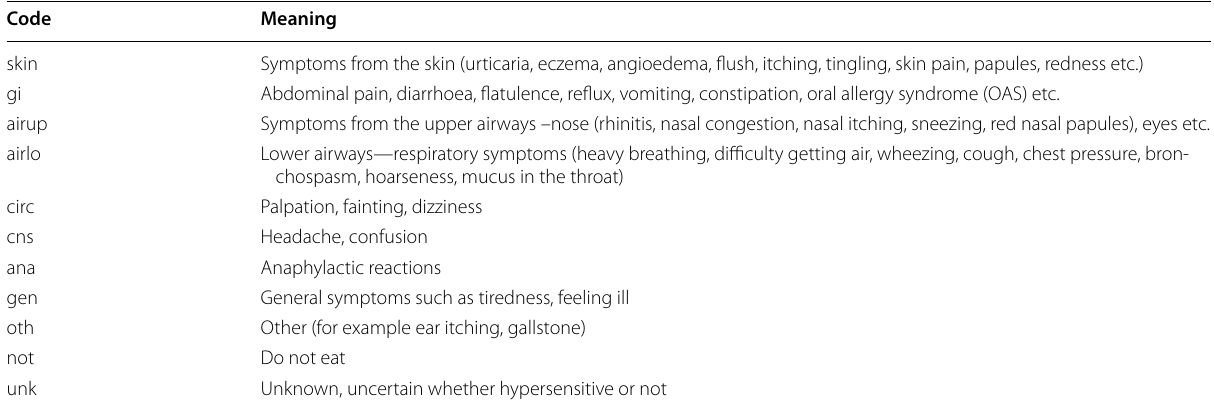
Table 2 Encoding of symptoms for self-reported hypersensitivity reactions in the food hypersensitivity